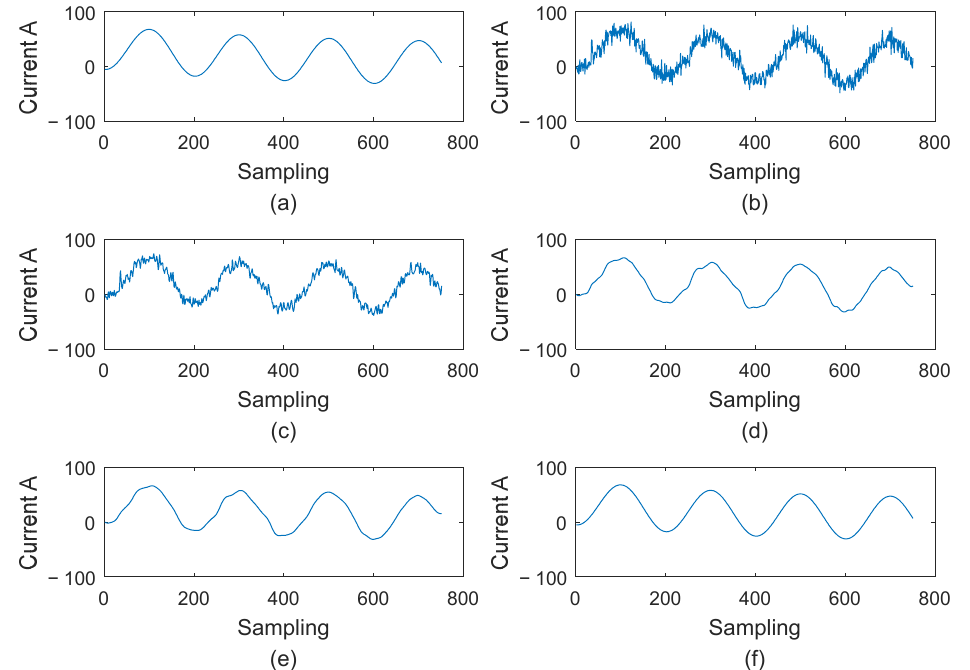
Figure 7. Trend filtering technology eliminates short-circuit current and white noise interfer- ence.( a ) Ideal waveform without any interference. ( b ) The addition of the white noise interference to the ideal waveform. ( c ) One-time filtering effect. ( d ) Fifteen filtering effect. ( e ) Thirty filtering effect. ( f ) Forty-five filtering effect.